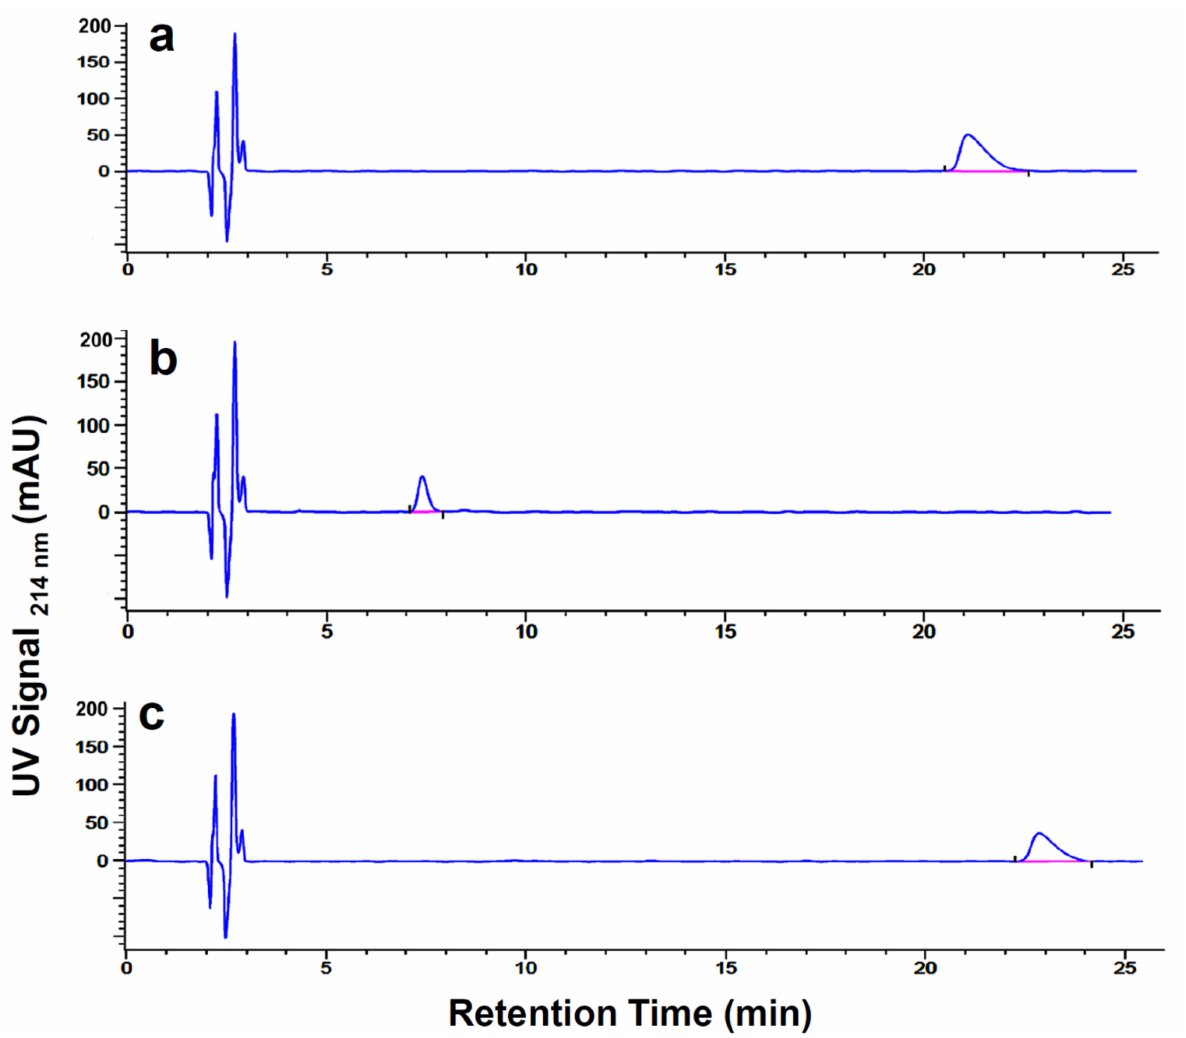
Figure 1. Representative HPLC-UV analysis (signal intensity at wavelength of 214 nm) of ( a ) DSP, ( b ) DOTA-[Thi 8 , Met(O 2 ) 11 ]SP, ( c ) SP (control). Isocratic HPLC analysis was performed using 75% solvent A (0.1% TFA in water)/25% solvent B (0.1% TFA in acetonitrile) on a Zorbax Stable Bond C18 (4.6 mm × 250 mm; 5 µ m) column (40 ◦ C, 1